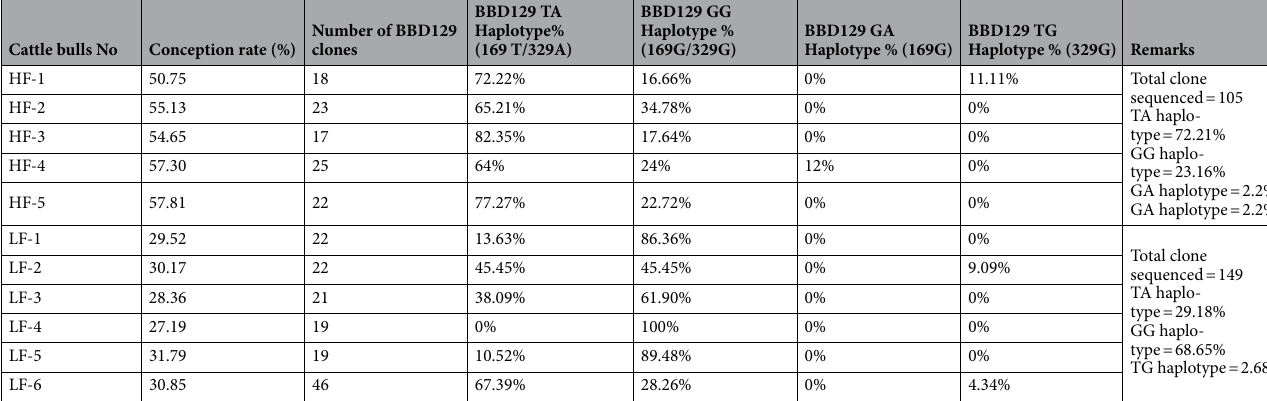
Table 1. The selection of high fertile and low fertile cross-bred bulls was done on the basis of percentage of their conception rate data available on the NDRI herd. The distributions of the percentage of different haplotypes of the BBD129 gene in the distinct fertility bulls were calculated from sequenced clones. HF , high fertile bull; LF , low fertile bull; Nucleotide polymorphism: G = Guanine, A = Adenine, T = Thymine, TA = 169th T & 329th A; GG = 169th G & 329th G; GA = 169th G & 329th A; TG = 169th T & 329th G; HF , High fertile; LF , Low